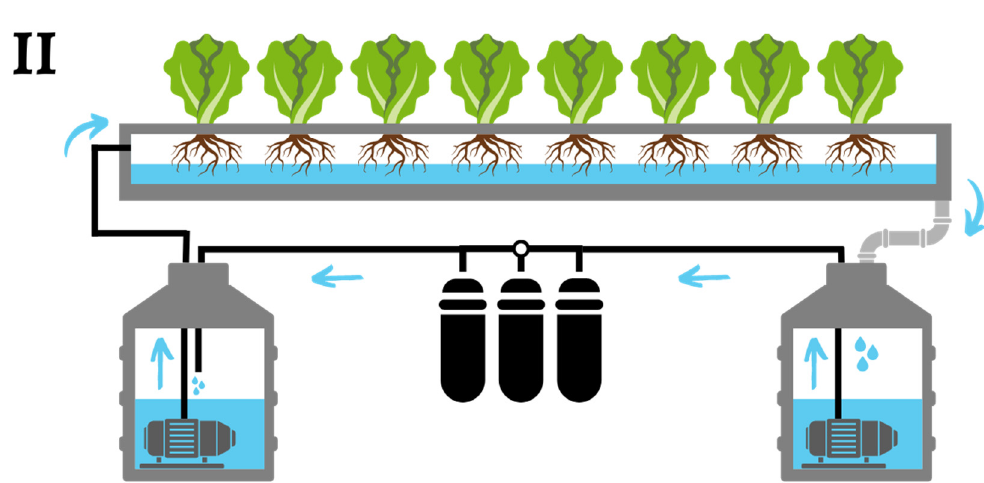
Figure 5. ( I ) A nutrient film hydroponic system comprised of two water pumps ( A , B ), two reservoirs